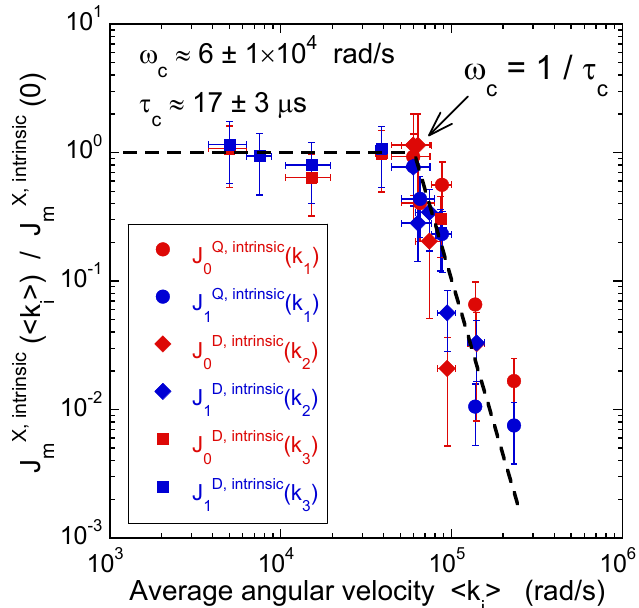
Figure 9. Dispersion curve determined from the variation of the quadrupolar and heteronuclear dipolar contributions to the relaxation of the T 11 ( s ) , T 21 ( a ) , T 21 ( s ) , and T 22 ( a ) , 2 H coherences mea- sured under spin-locking conditions. Reprinted with permission from Ref. [80]. Copyright (2014) American Chemical